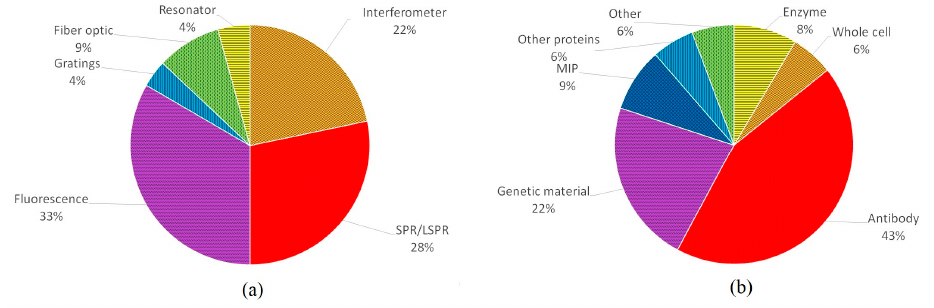
Figure 10. Percentage distribution of the works consulted according to ( a ) the type of biosensor and ( b ) the biological recognition element. ( b ) the biological recognition